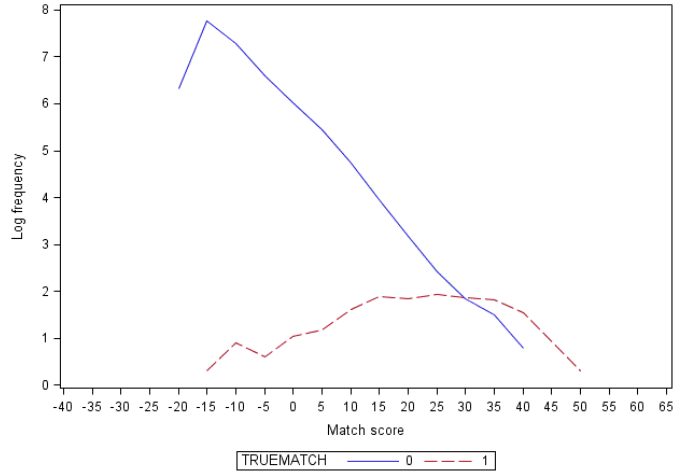
Supplemental Figure 2: Log frequency of match scores calculated for all pairwise comparisons using limited algorithm, by